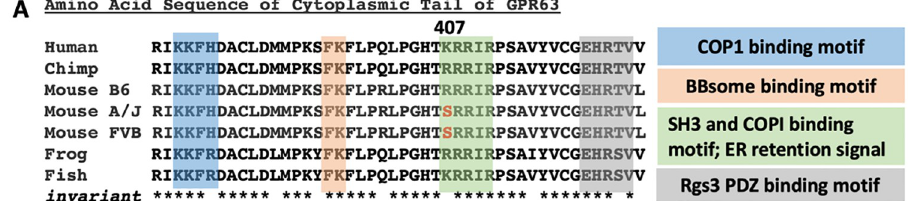
Fig 5. Gpr63 is a conserved gene. Amino acid sequence of GPR63 from multiple species and three inbred strains of mice. Invariant amino acids are indicated with � . Shading indicates amino acids composing four putative functional domains in the cytoplasmic tail of GPR63.